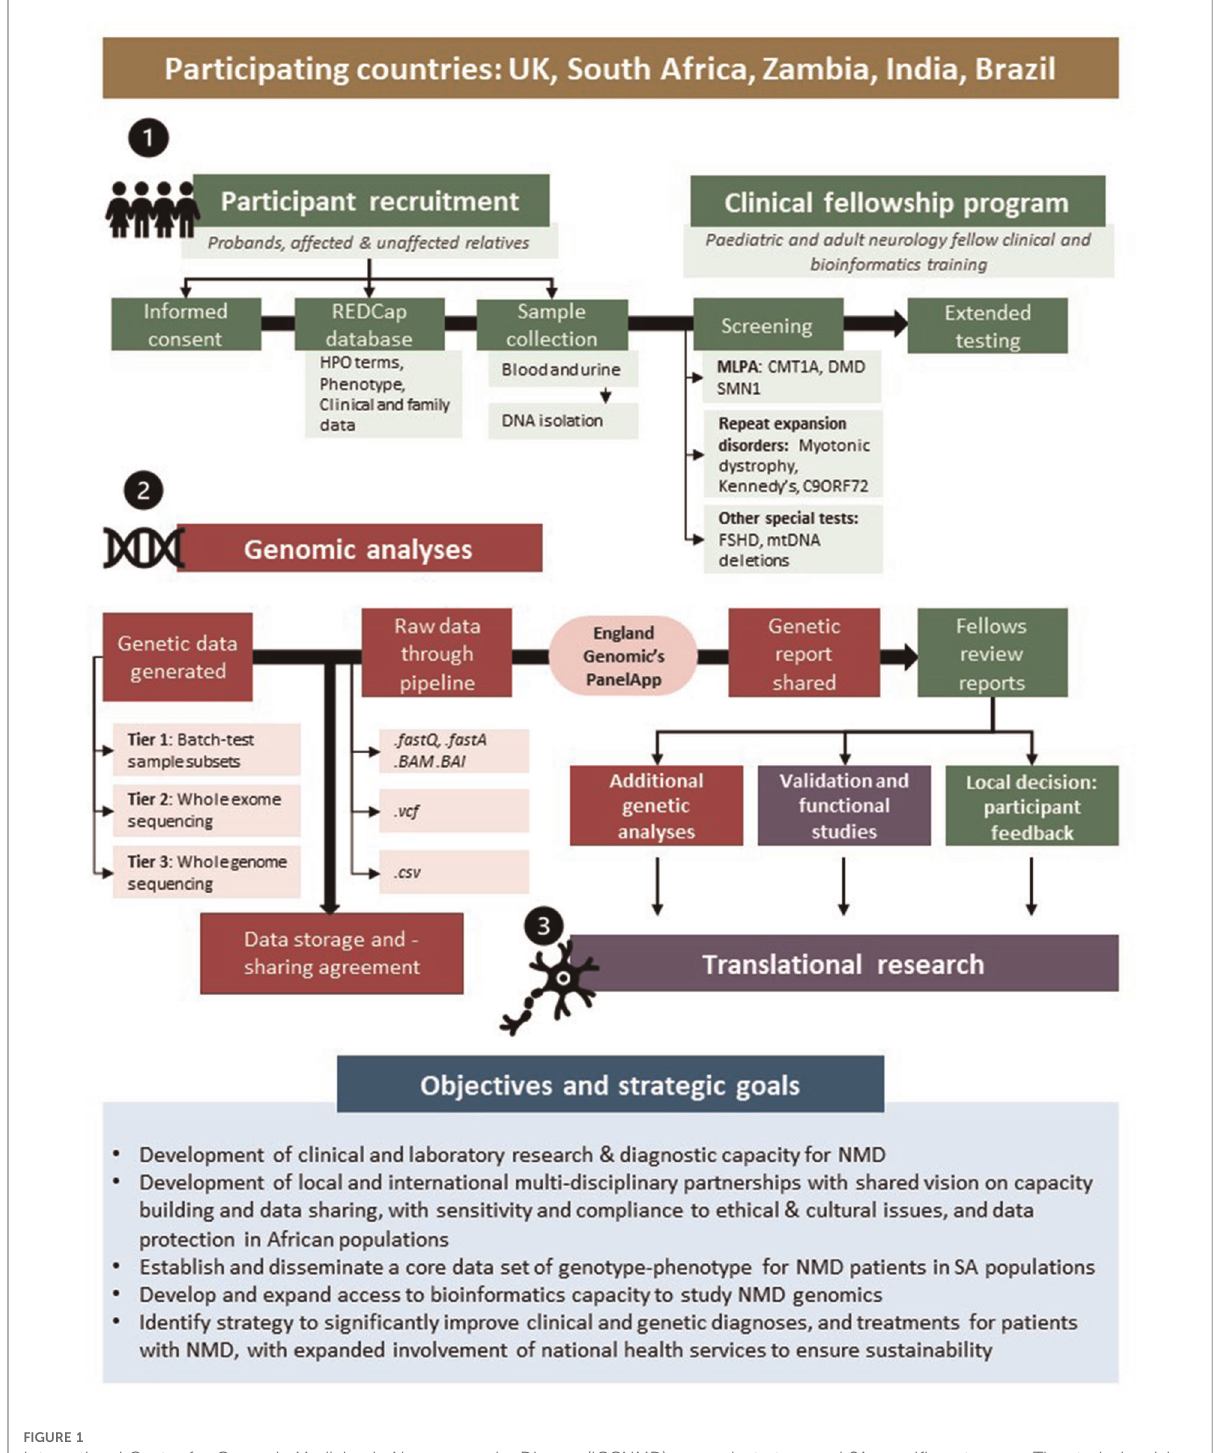
FIGURE 1 International Centre for Genomic Medicine in Neuromuscular Disease (ICGNMD) research strategy and SA-speci fi c outcomes. The study, involving four South African academic centres as part of a six-nation global NMD genomic study, is structured in three phases: a clinical fellow training- ( 1 ), genomic- ( 2 ), and translational phase ( 3 ). Green indicates local clinical fellow involvement; red indicates collaborative genomics strategy and purple speci fi c collaborative follow-up studies where novel fi ndings are